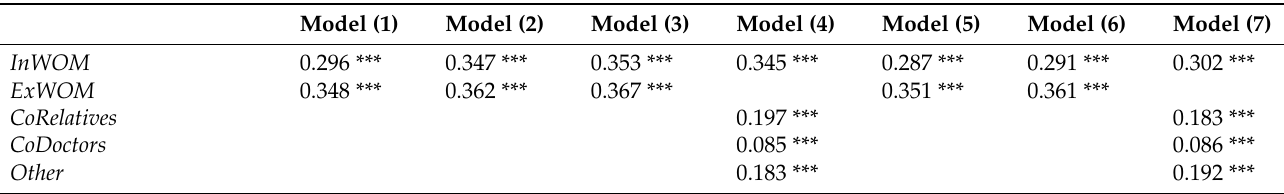
Table 3. Hierarchical regression results using